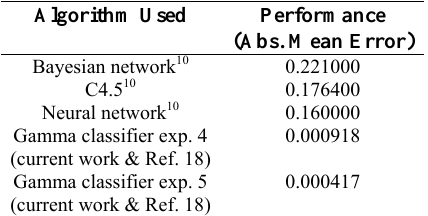
Table 5. Comparison of related results (SIMAT database, O 3 ) in absolute mean error given for pollutant concentration in ppm; exp. means “experiment”.